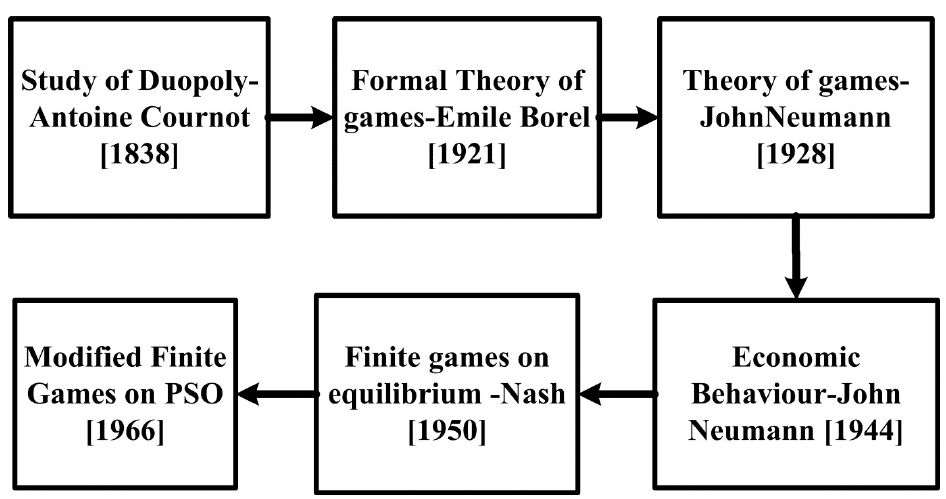
Figure 2. Game theory evolution-based optimization approach of typical IHMS [69]. Table 2. Stochastic optimization techniques adopted by researchers for